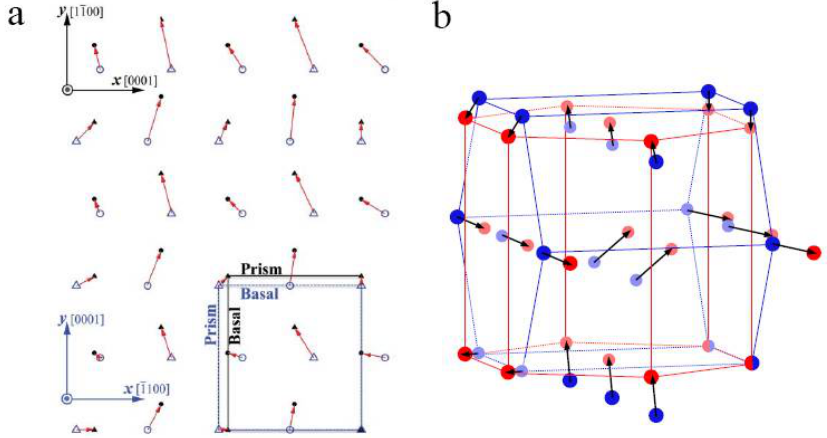
Figure 30. Shuffle models of extension twinning in hcp metals proposed by ( a ) Wang et al., and by ( b ) Liu et al. Reprinted from [137] and from [131], respectively, with permission from Nature Publishing Group.